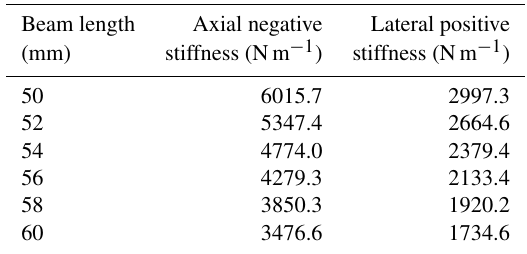
Figure 6. In-plane lateral force–displacement curve of the conven- tional bistable mechanism at the unstable equilibrium point. Table 2. Values of the axial negative stiffness and the in-plane lateral positive stiffness at the unstable equilibrium point of the bistable mechanism when changing the beam length L